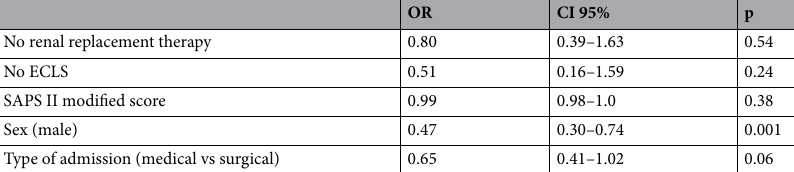
Table 3. Multivariate logistic regression model for being in the fatigued group. Variables with an OR < 1 are protective. SAPS Simplified Acute Physiology Score, ECLS emergency extracorporeal life support.